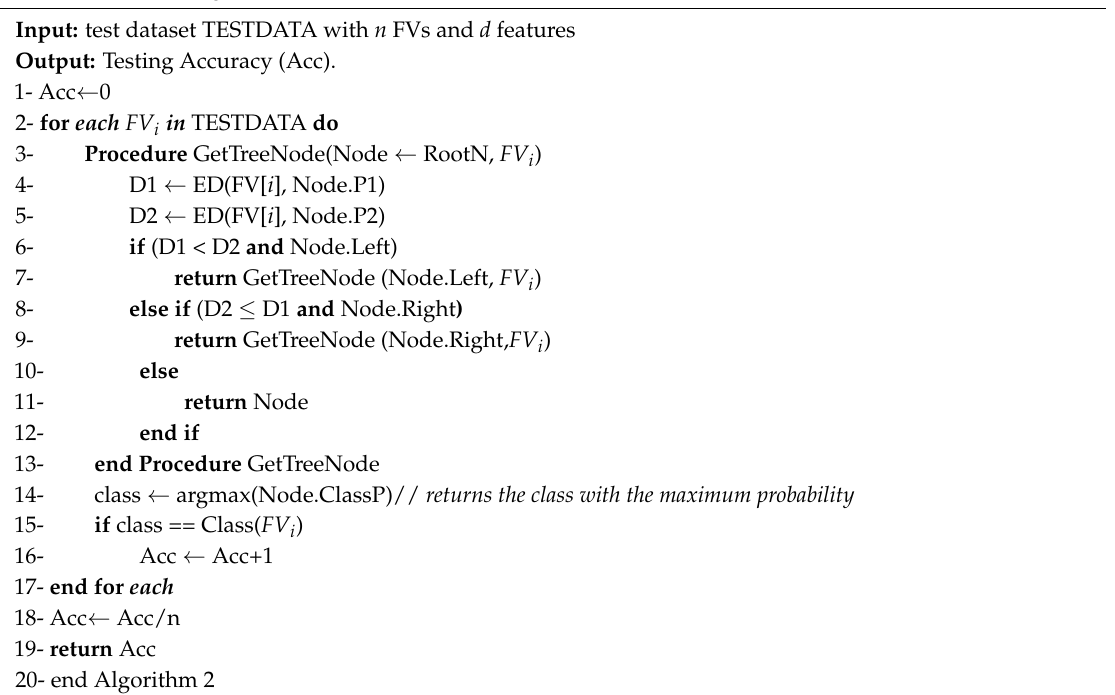
Algorithm 2. Testing Phase of